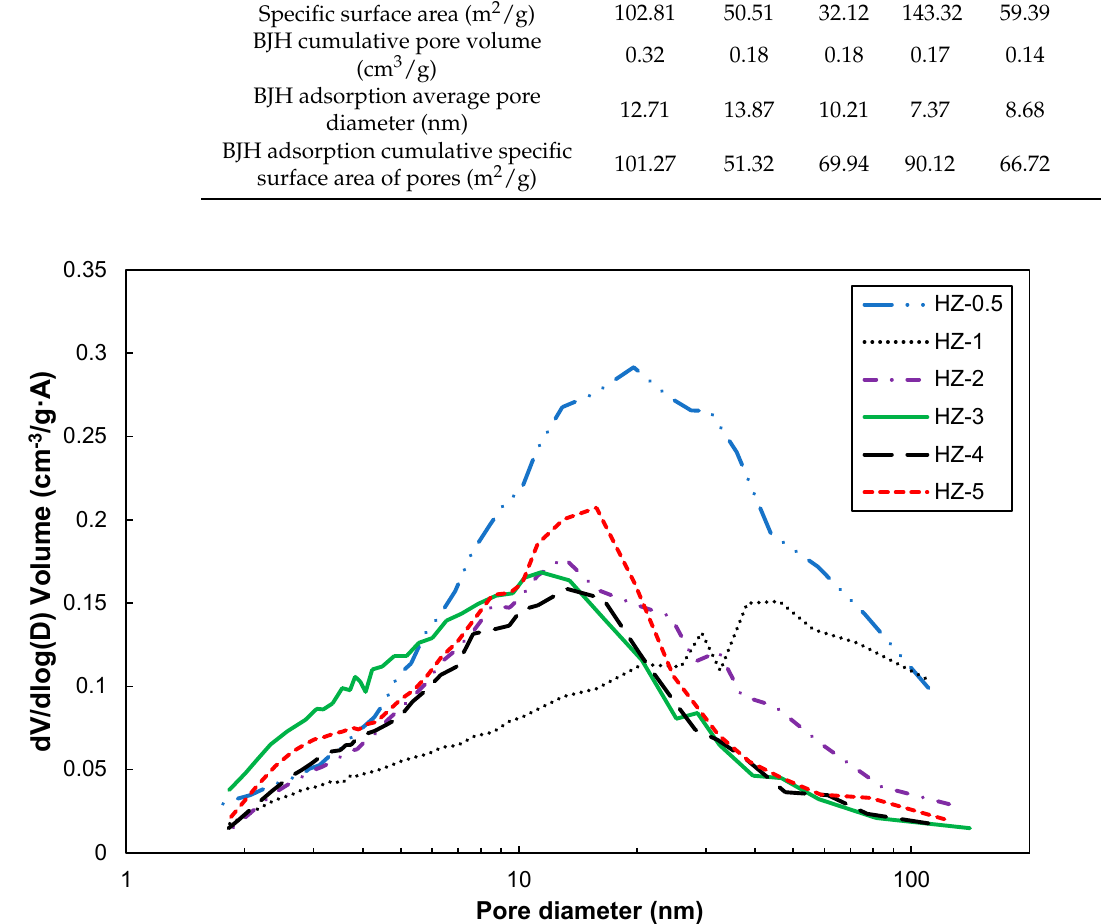
Figure 5. The pore size distributions of the synthesized composite samples measured from the BJH tests.